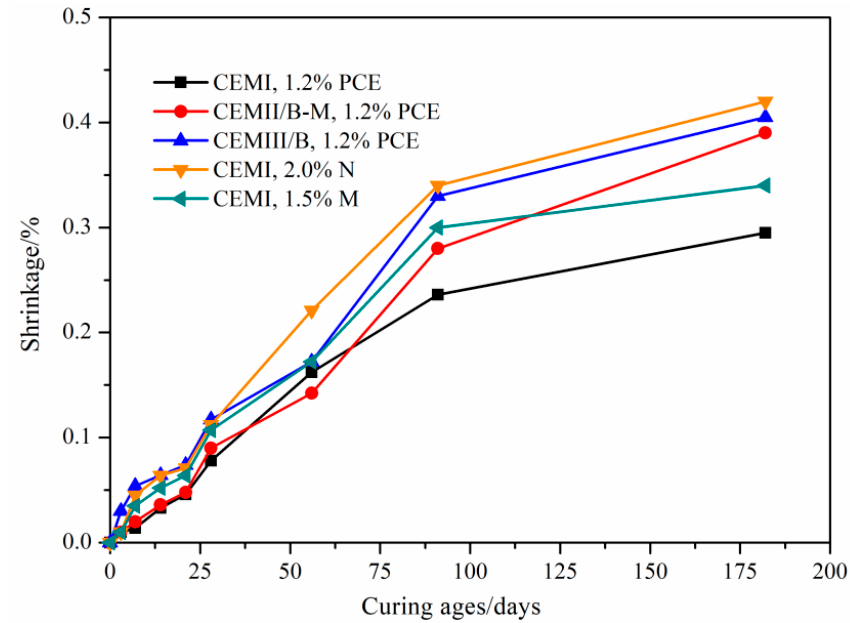
W/S. Figure 15 shows the FS/USC ratio of SMCG with key formulations. In comparison, the 3-day and 28-day FS/UCS ratios of CEM I SMCG were 0.20 and 0.19 at the W/S of 1.0, and the 28-day FS/UCS ratio was 0.25 at the W/S of 1.5. The 0.6–1.5% PCE, 1.5–2.0% N and 1.2% M can enhance the FS/UCS with different degrees; this might indicate that they have more bending or shearing resistance energy, and it is helpful for improving the brittleness of SMCG. The 28-day FS/UCS ratios of CEM I SMCG with 1.0% N were relatively low (0.13–0.21) at the W/S of 1.0 or 1.5; this might be because the 1.0% content of N is relatively low to improve the FS/UCS. It was observed that the FS/UCS tended to be affected seriously by UCS values because the UCS was generally much higher than FS. The effect of a single factor such as curing day, W/S, cement type or SP was not obvious and there existed some randomness. The FS/UCS or brittleness evaluation should be combined with the specific values of FS and UCS.